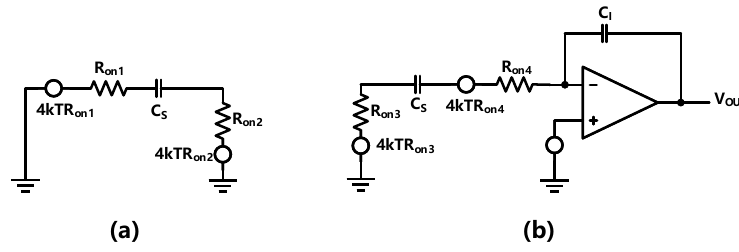
Figure 2. Noise model of the integrator in ( a ) sampling phase ( b ) integrating